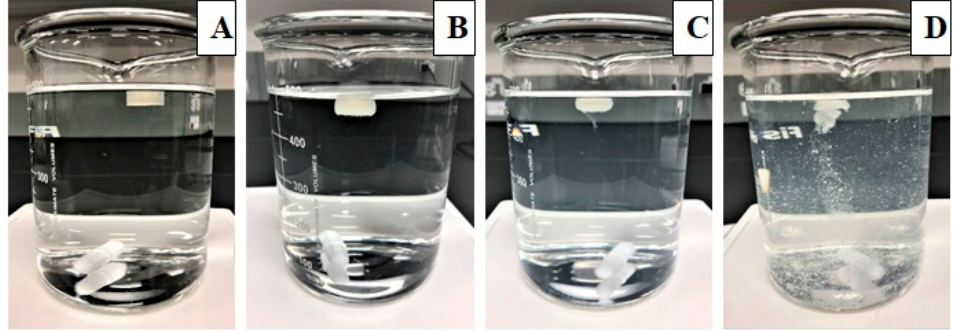
Figure 5. Images of the floating tablets taken at different time points during the dissolution study in 0.1 N HCl: 0 h ( A ), 2 h ( B ), 4 h ( C ), and 6 h ( D ).